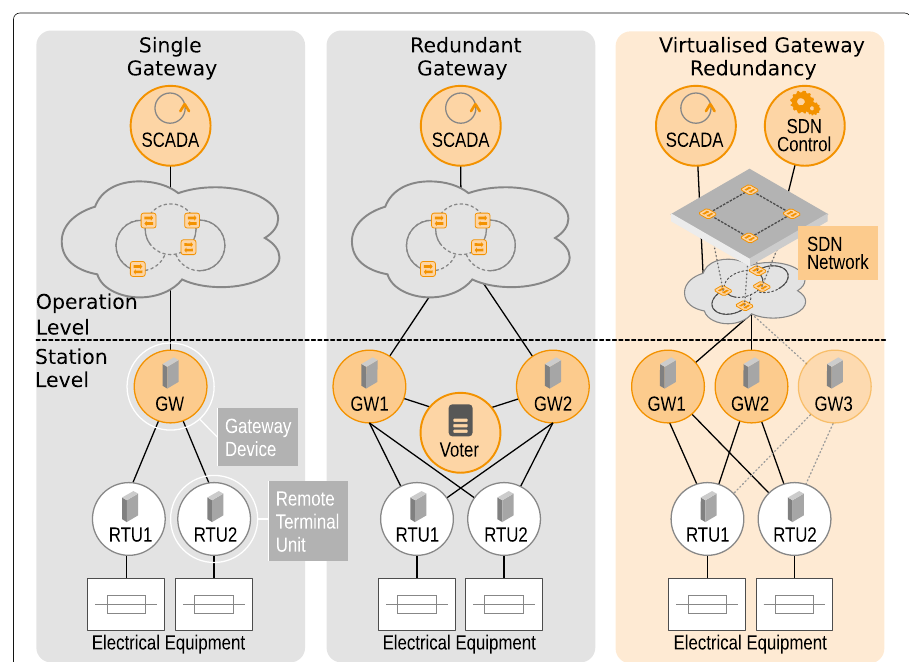
Fig. 1 Compared to traditional implementations (single and redundant gateway), virtualisation provides flexible redundancy solutions with low configuration